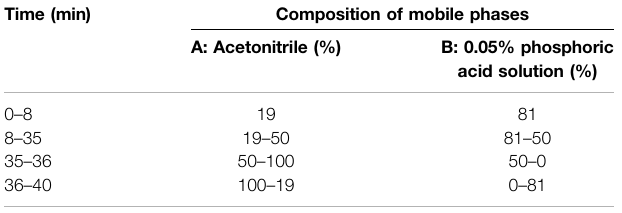
TABLE 3 | Details of treatments used in this